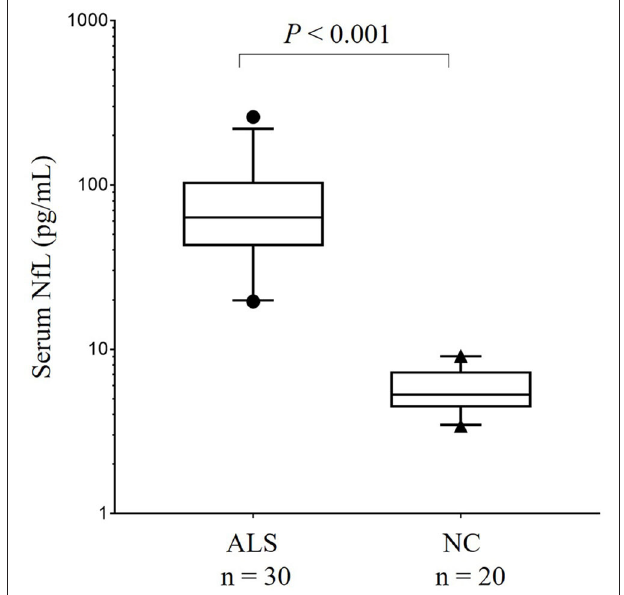
FIGURE 1 | The comparison of serum NFL concentration between patients with ALS and HCs in China. Serum NFL concentration in patients with ALS and HCs. Given are the median concentrations, 25th and 75th percentiles, and 5 and 95% whiskers. Points represent values below 5% percentile and above 95% percentile. ALS, Amyotrophic lateral sclerosis; HCs, Healthy controls; NFL, Neurofilament light chain.